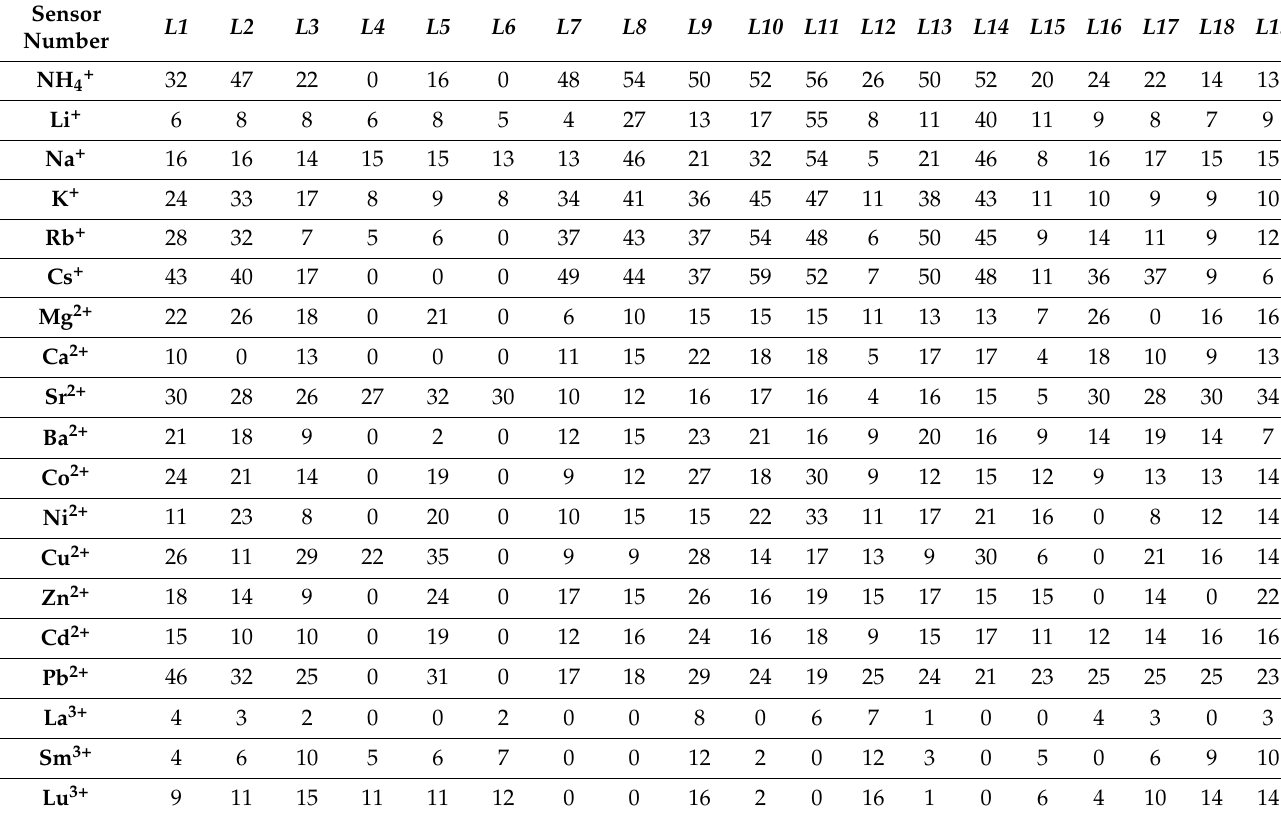
Table 2. Sensitivity values ( ± 1 mV/dec) of the sensors in aqueous solutions of metal ions. In the case of lanthanides, the measurements were performed at pH 2 (fixed by nitric